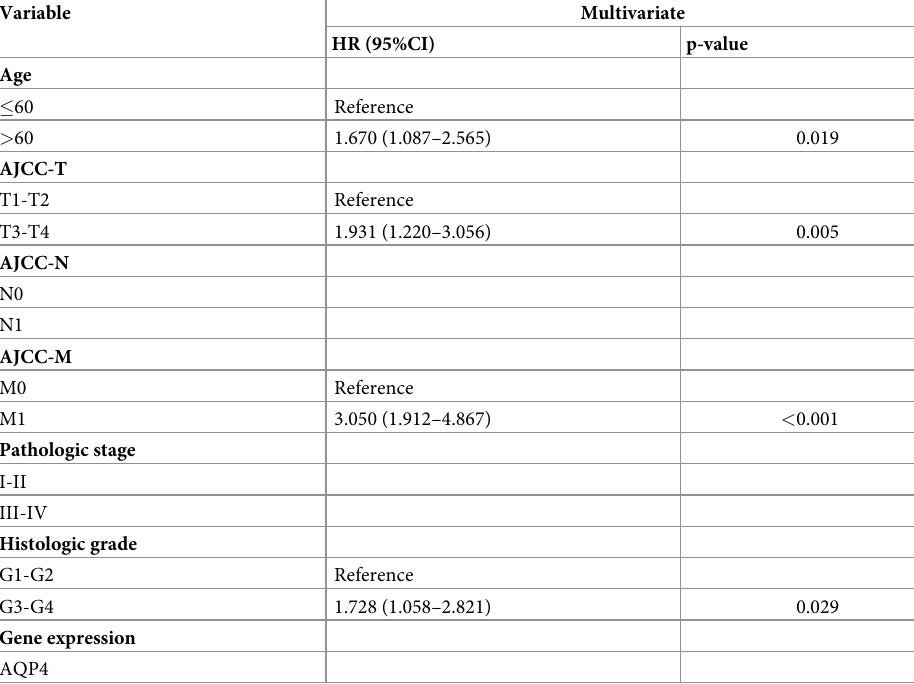
Table 7. Multivariate analysis of overall survival in 526 ccRCC patients.